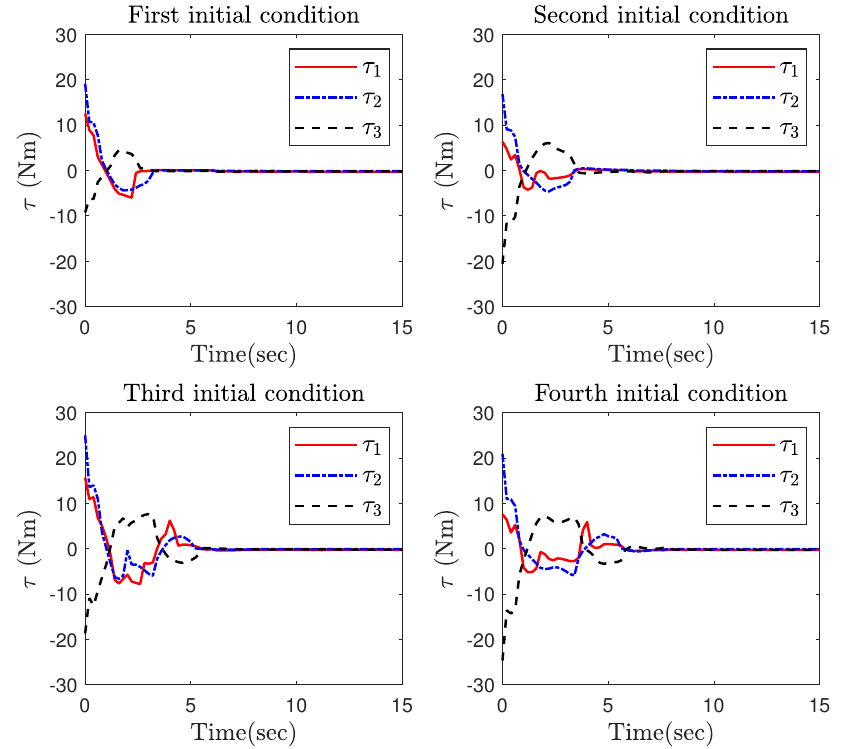
Figure 7. The control input in Part